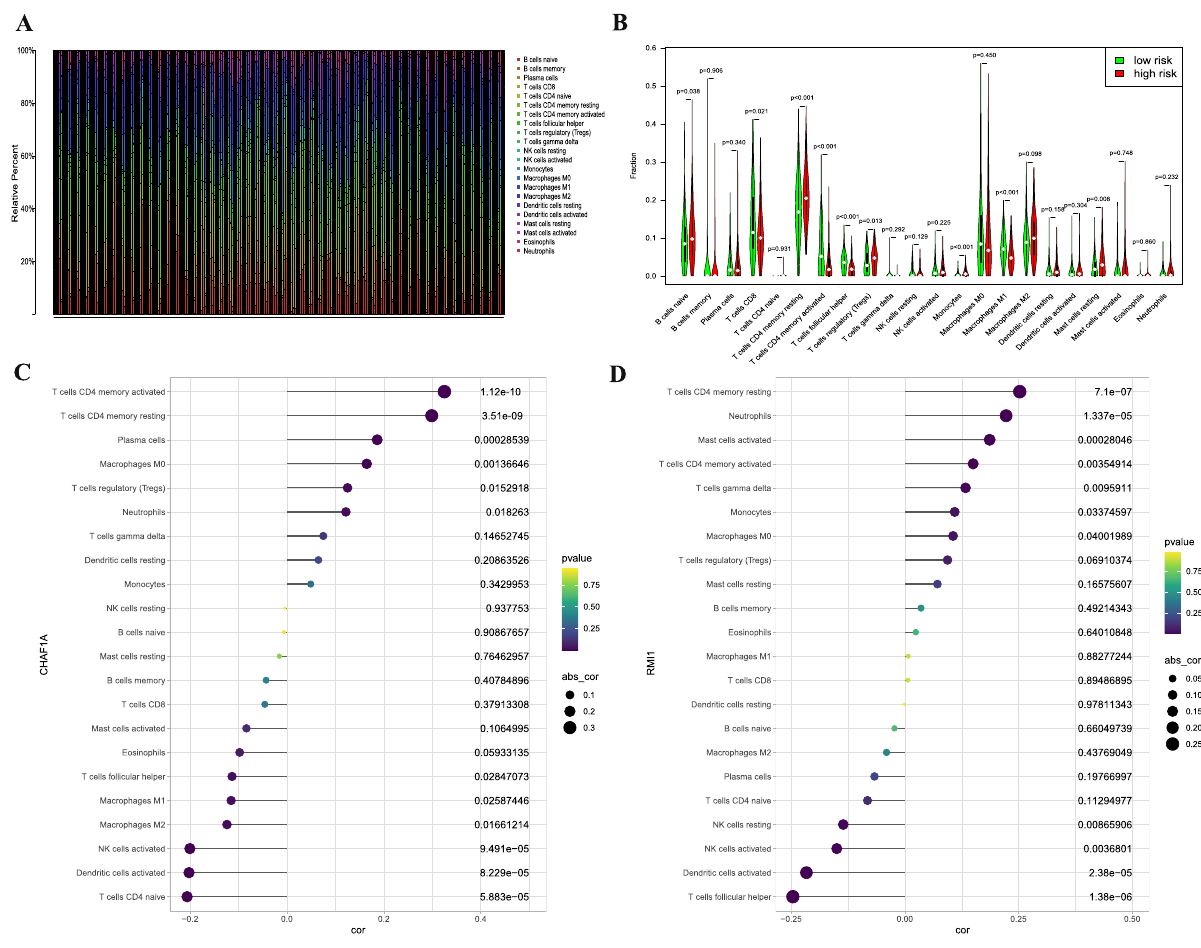
Figure 6. Distribution and visualization of immune cell infiltration in patients with GC and the correlation between two DNA repair genes. Summary of estimated compositions of 22 immune cell subtypes from the CIBERSORT algorithm in GC patients ( A ); Comparison of 22 immune cell subtypes between low- and high-risk samples ( B ). The correlation between CHAF1A ( C ) and RMI1 ( D ) and infiltrating immune cells in patients with